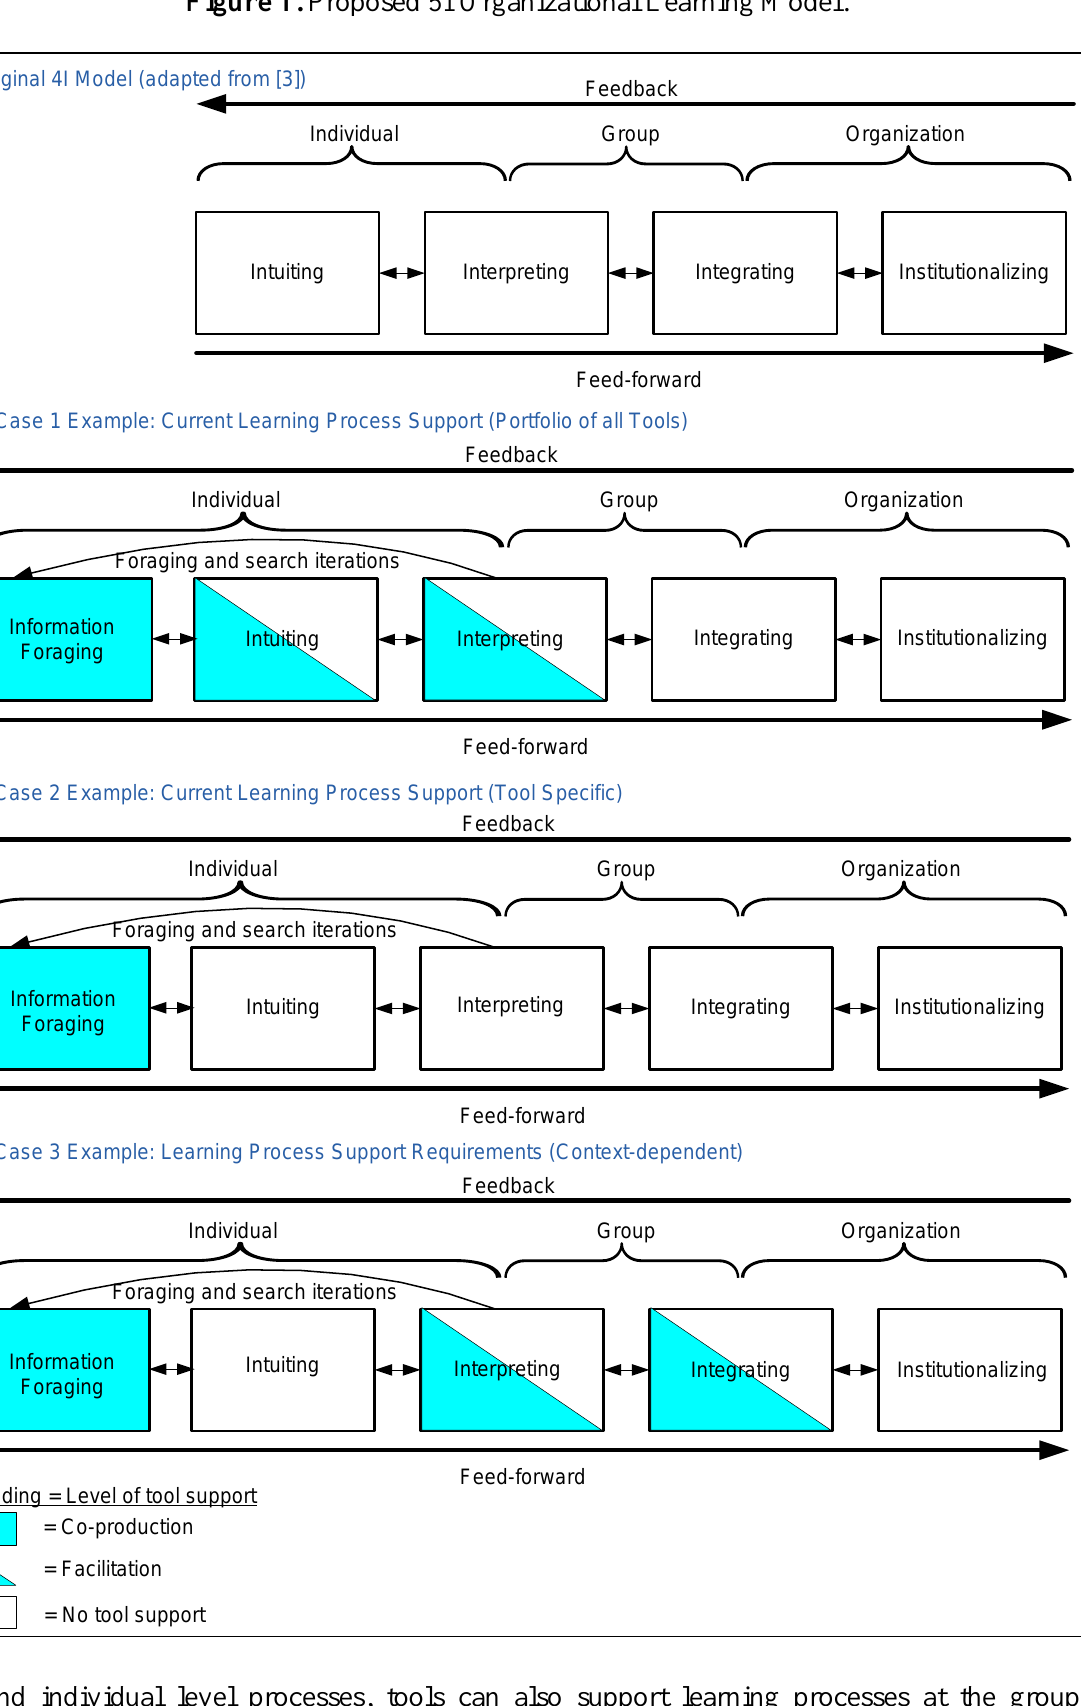
Figure 1. Proposed 5I Organizational Learning